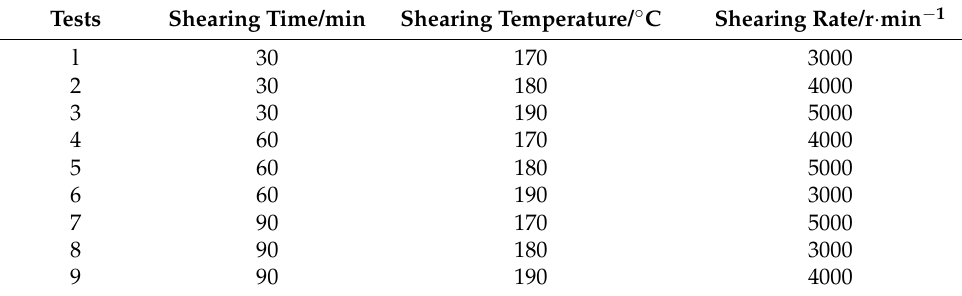
Table 4. Orthogonal test design